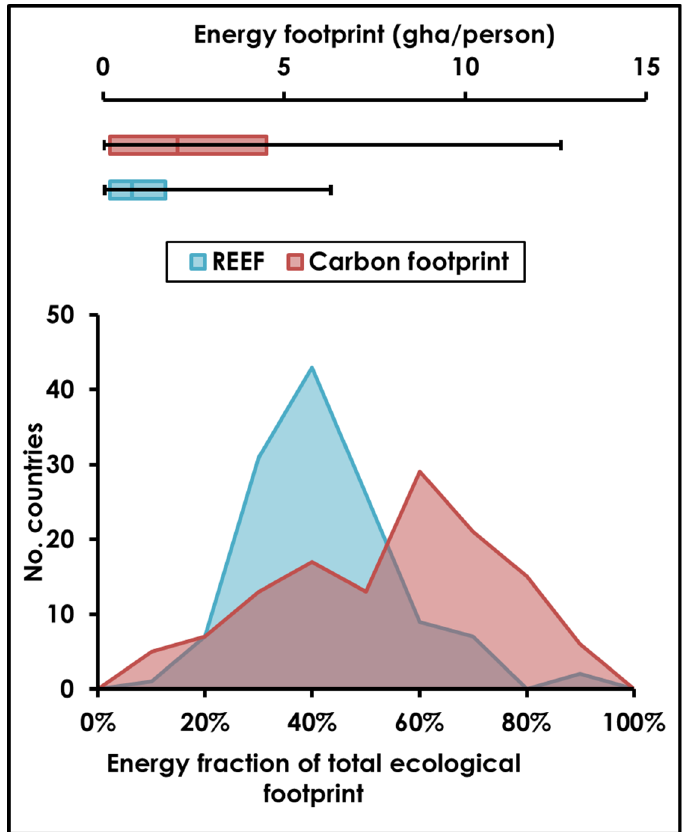
Figure 7. Range of REEF and carbon footprints, and distribution of energy as a fraction of total ecological footprint by country. For the footprint size, the boxplot shows 10th and 90th percentiles, with a mid-line at the (unweighted) mean across countries and error bars extending to the minimum and maximum.